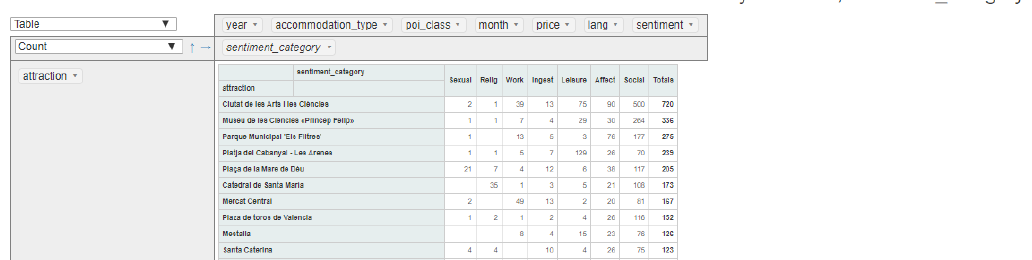
Figure 14. Tweets per attraction and sentiment category.